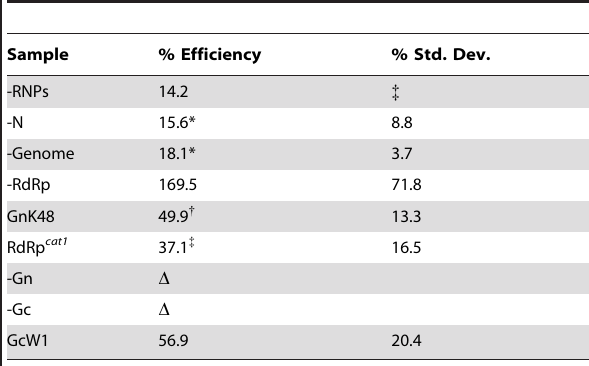
Table 2. Gc cytosolic tail is dispensable for infectivity. Sample